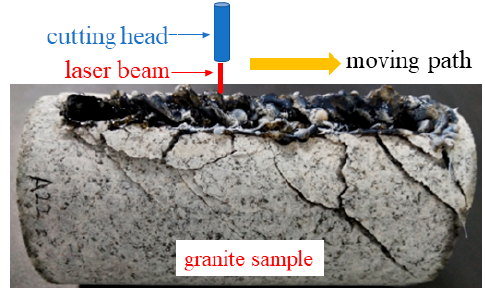
Figure 2. Schematic of moving laser irradiation.